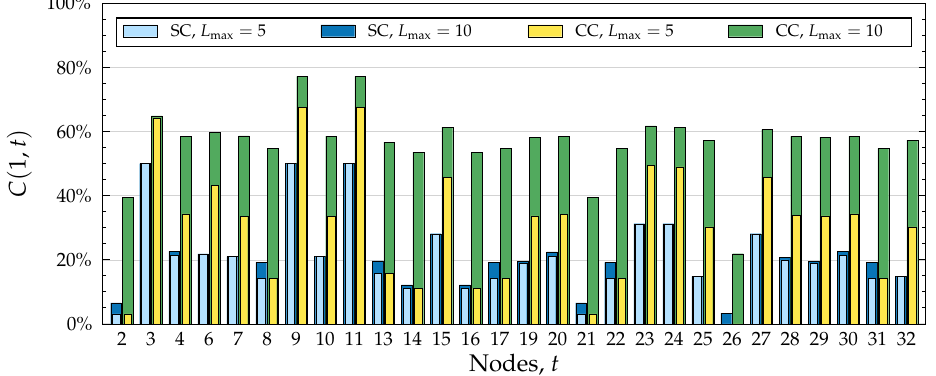
Figure 3. Comparison of SC and CC models using spreading probabilities calculated in the Dutch Student network (see Figure 6 where node 1 is highlighted) with λ = 1, T → ∞ , and w ( u , v ) = 0.5 for all ( u , v ) ∈ E . The graph depicts, for each node t , the probability of spreading from node 1 to node t . Two different path lengths are used, L max = 5 and L max = 10.